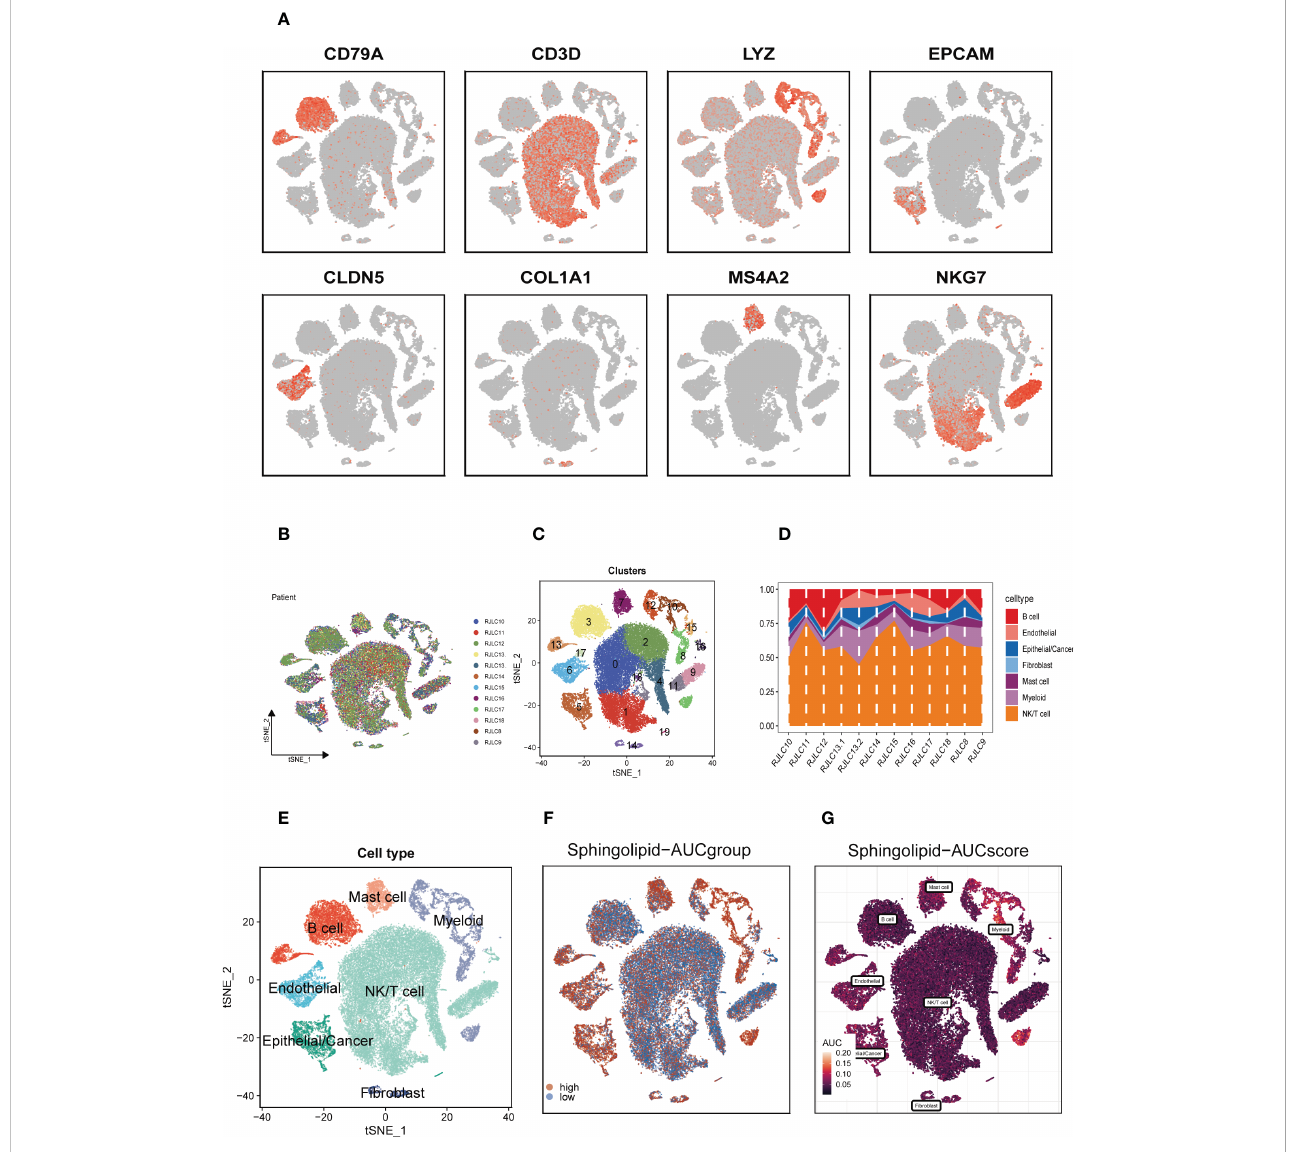
FIGURE 2 Annotation of single-cell data and SM activity. (A) Typical marker genes for each cell group. (B) The t-SNE plot showed that all the cells in the 12 LUAD samples. (C) The t-SNE plot showed that all the cells in 20 clusters. (D) Different proportions of cells in 12 samples. (E) The t-SNE map indicates that LUAD samples can be annotated as 7 cell types in the TME (different colors represent different cell types). (F, G) AUCell score and groups of SM activity in each